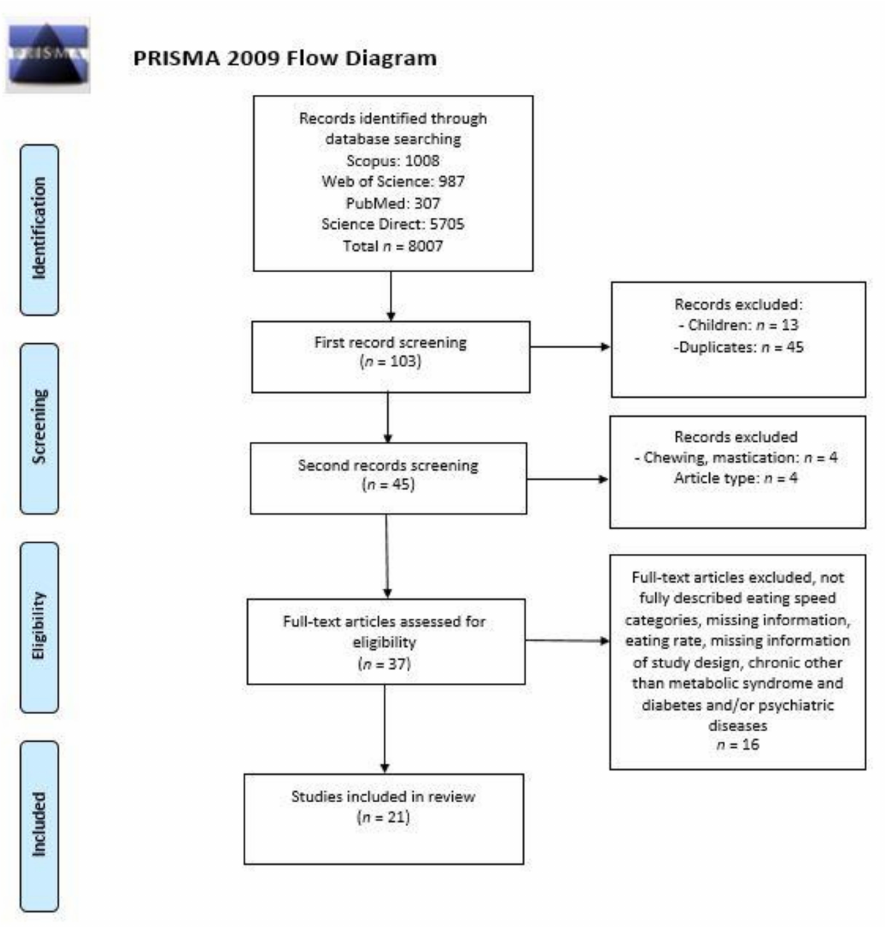
Figure 1. Procedure of identification and screening process for selecting reviewed articles exploring the relationship between eating speed and obesity indicators in